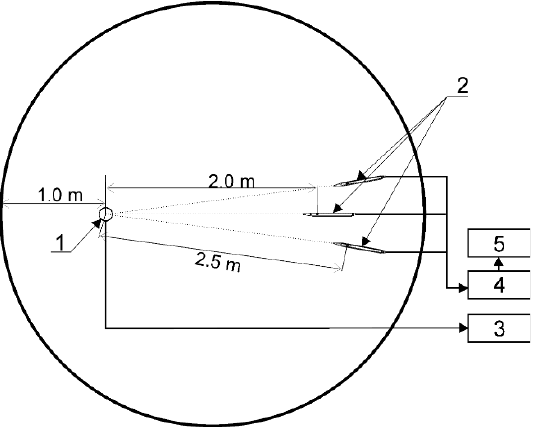
Figure 2. Diagram of system for air blast wave overpressure measurement. 1—explosive